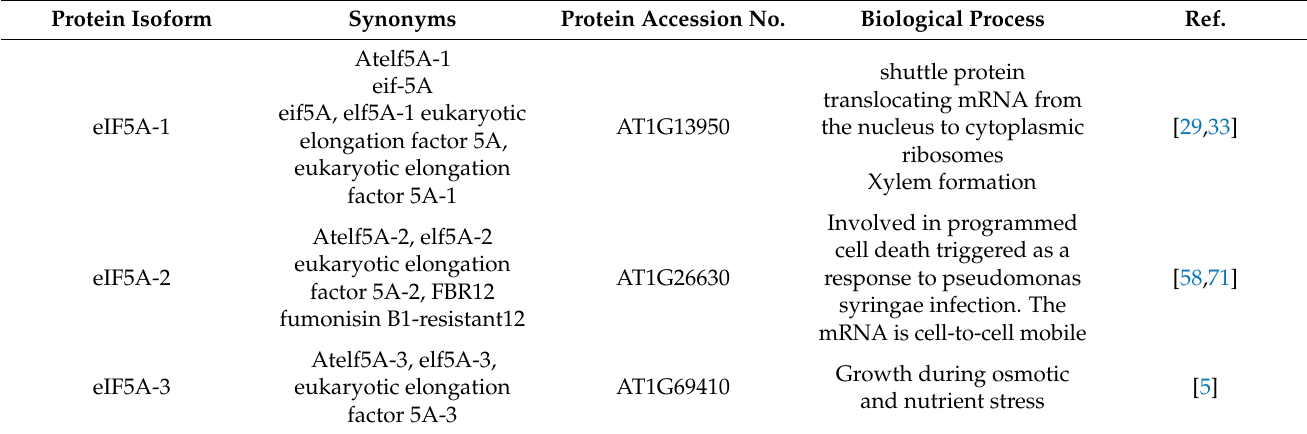
Table 1. The diverse roles of eIF5A isoforms in Arabidopsis thaliana . Protein Isoform Synonyms Protein Accession No. Biological Process